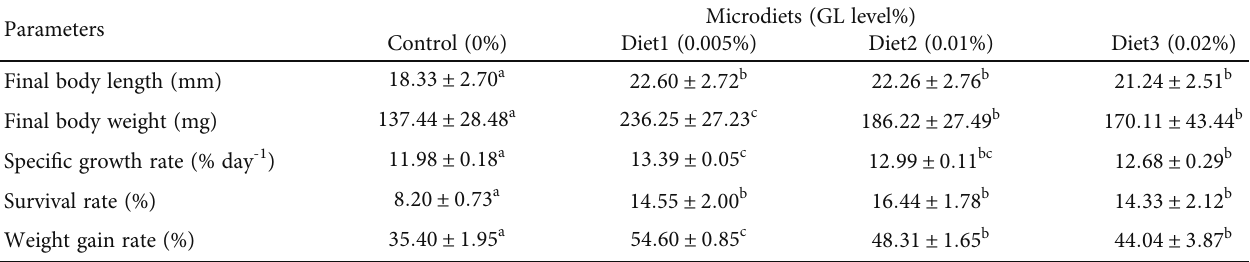
Table 3: E ff ects of GL supplementation on survival and growth performance of large yellow croaker